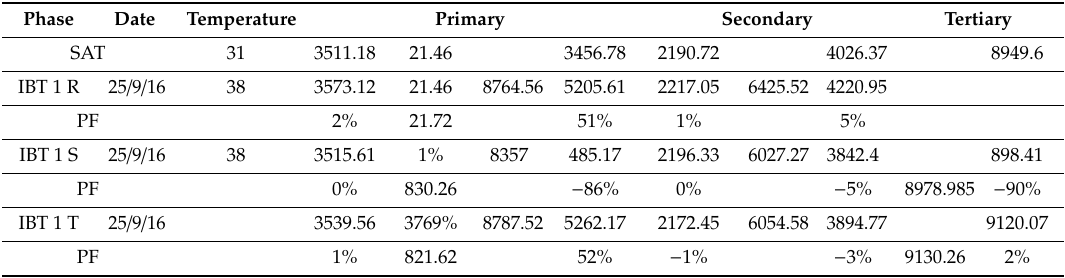
Table A7. Winding